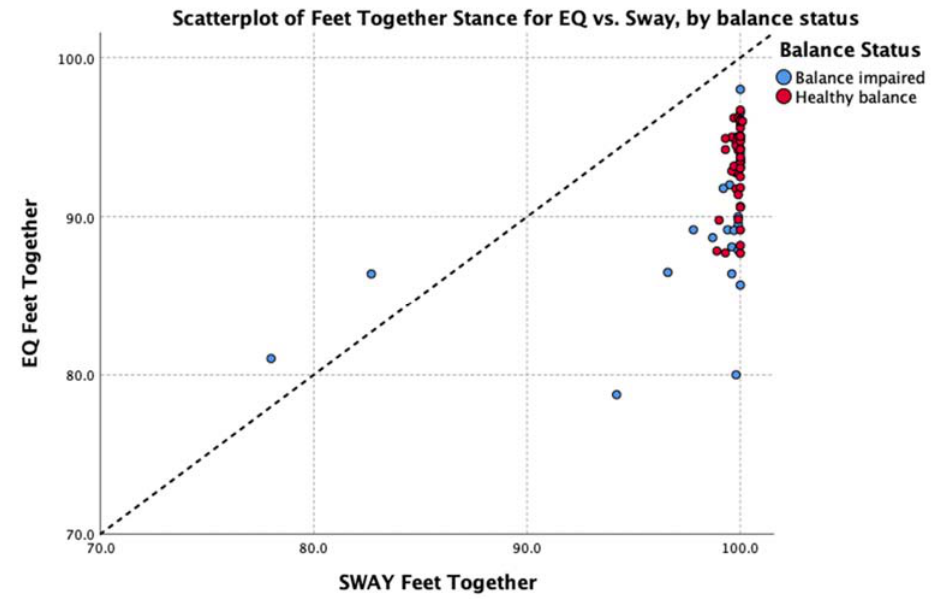
Figure 6. Scatterplot of feet together balance results in the healthy group.